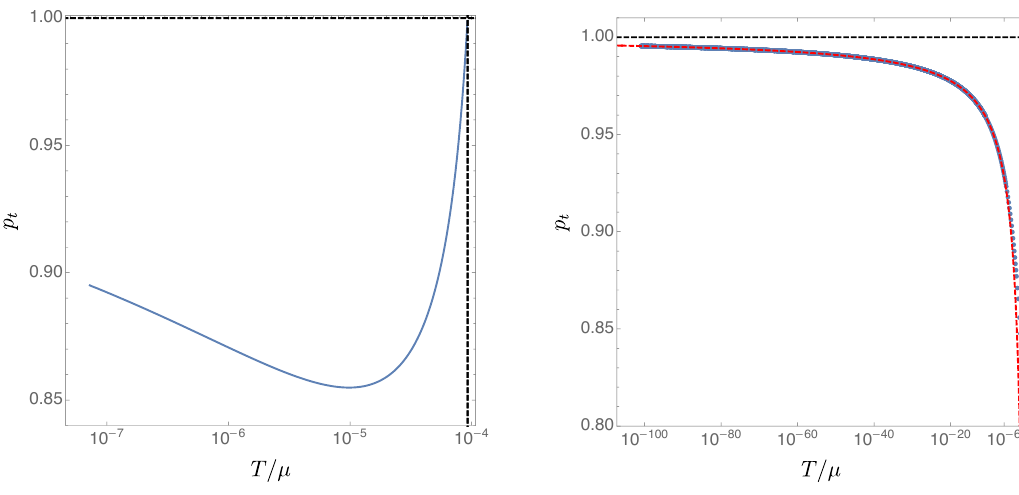
Figure 6 . Left : Near-singularity Kasner exponent p t at (cid:30) 9 : 26 (cid:2) 10 (cid:0) 5 (cid:22) (vertical dashed line) at which the scalar spontaneously condenses. For T > T c , p t = 1. Right : Near-singularity Kasner exponent p t in a linear (cid:0) log scale as a function of T=(cid:22) , at constant (cid:30) =(cid:22) = 1. The red dashed line shows a one-parameter (cid:12)t to (5.3) with (cid:11) = a 0 [ (cid:0) log( T=(cid:22) )] 1 = 2 in (0) the range T=(cid:22) 2 (10 (cid:0) 100 ; 10 (cid:0) 6 ). For this run, we obtained a 0 ’ 1 :